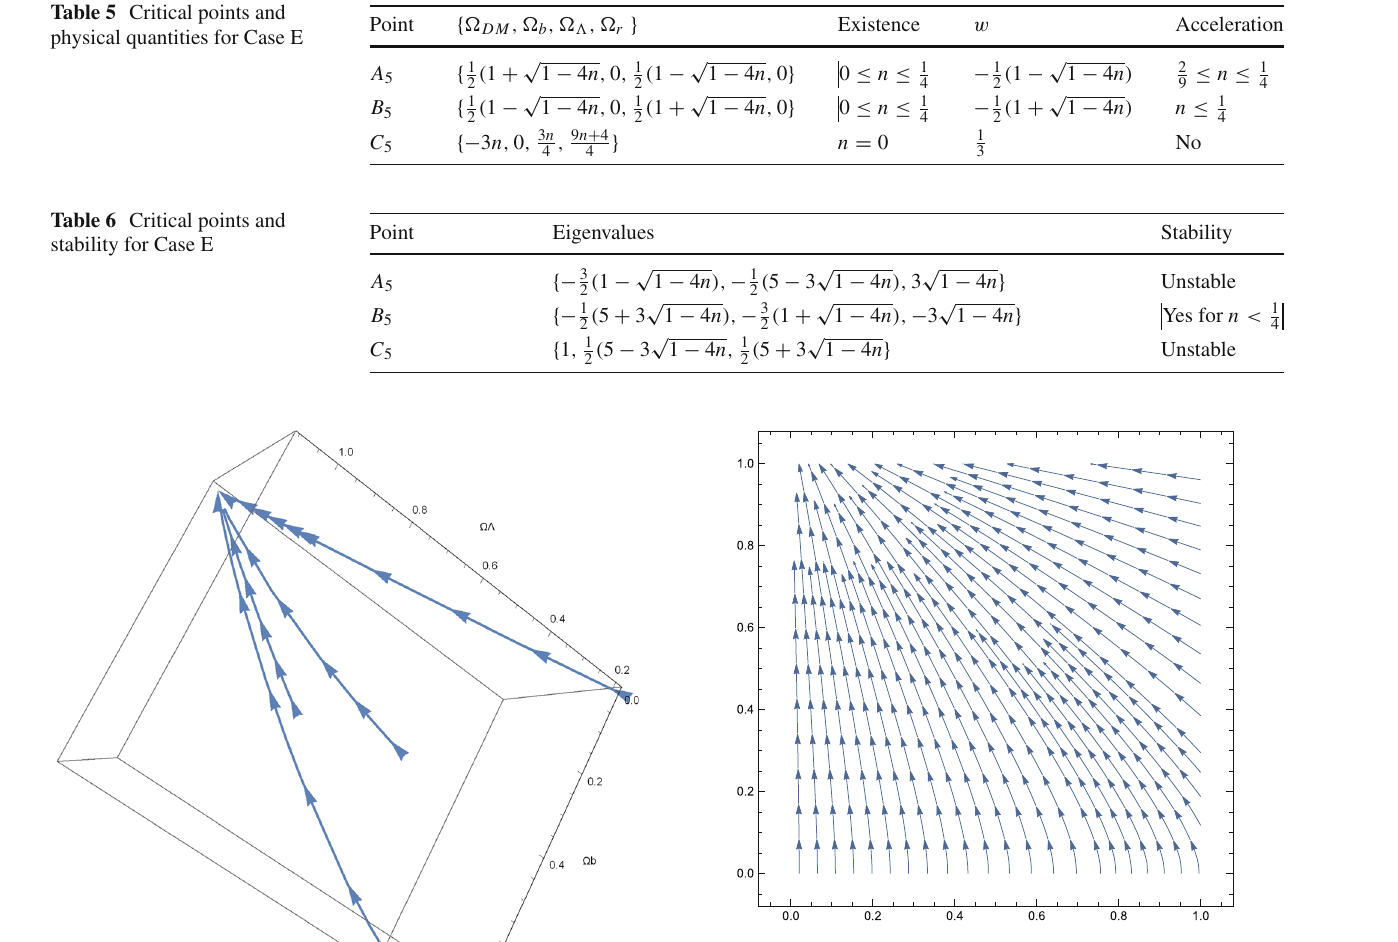
Fig. 10 Phase space diagram for the dynamical system (16), (17), (23) inthespaceofvariables (cid:8) b ,(cid:8) (cid:2) } for n < 1and (cid:8) r = 10 − 4 .Theunique attractor is the point B Fig. 9 Phase space diagram for the dynamical system (16), (17), (23). We consider (a) (cid:8) b = 0 . 2996 ,(cid:8) r = 0 . 0004, (cid:8) (cid:2) = 0 . 7, (b) (cid:8) b = 0 ,(cid:8) r = 0 . 1, (cid:8) (cid:2) = 0 . 9, (c) (cid:8) b = 0 . 3, (cid:8) r = 0 . 2, (cid:8) (cid:2) = 0 . 5, (d) (cid:8) = 0, (cid:8) = 0 . 5, (cid:8) (cid:2) = 0 . 2, (e) (cid:8) = 0 . 7, (cid:8) = 0 . 1, (cid:8) (cid:2) = 0 . 2, for b r b r